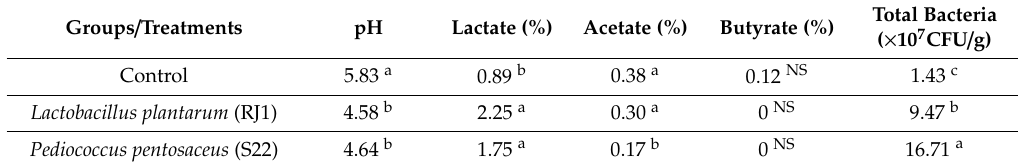
Table 4. Analysis of pH, microbial population, and organic acid concentrations of high-moisture LAB ( L. plantarum RJ1 and P. pentosaceus S22)-inoculated and non-inoculated crimson clover silage on day 180 of incubation. Data represent mean values ± SD ( n = 3), and superscript letters (a, b, c) within the same column are significantly di ff erent at p < 0.05. NS: not significant at p <